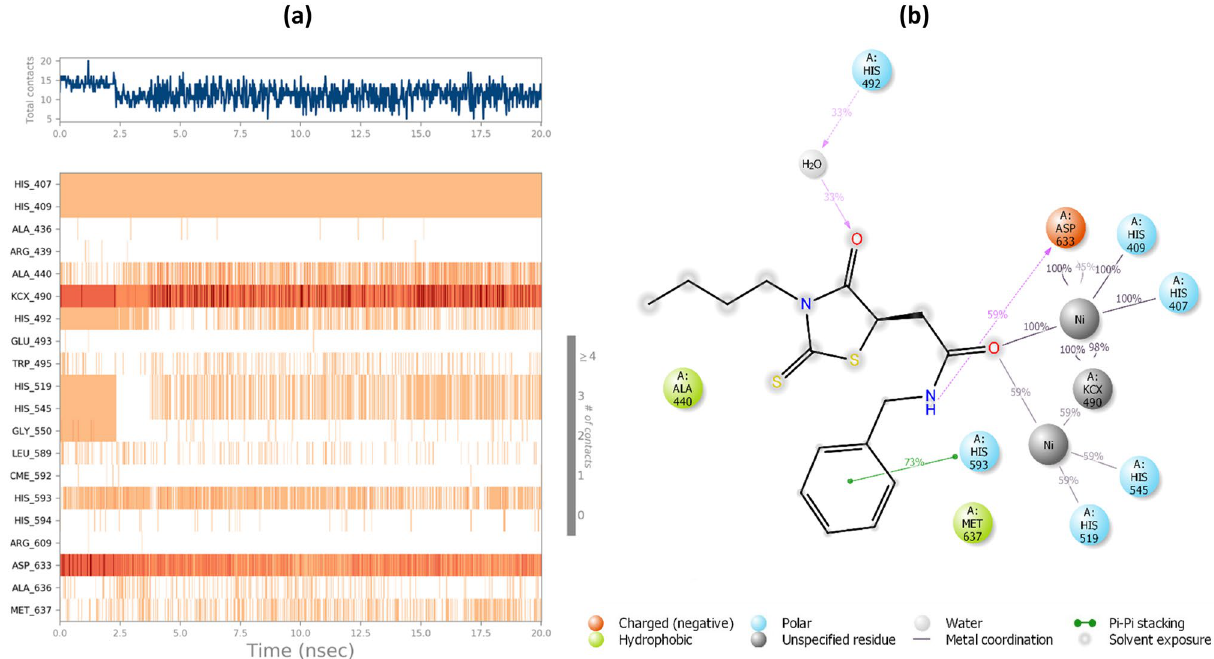
Figure 6. Timeline rendering of interacting residues during the whole simulation time in urease complexed with compound 6i ( a ). 2D representation of ligand-residue interactions ( b